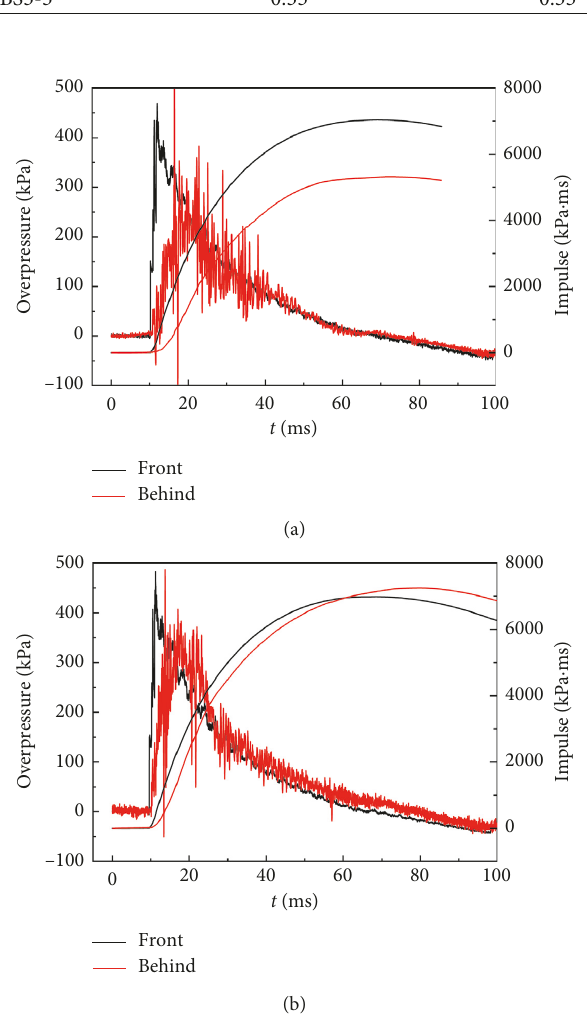
Figure 9: Typical overpressure and impulse history. (a) BS2-2.